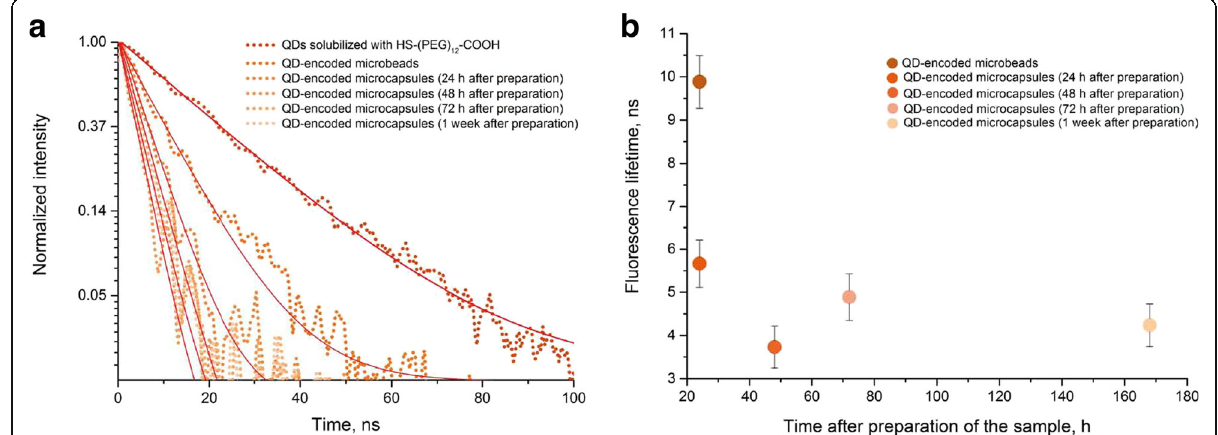
Fig. 8 Fluorescence lifetimes of the solubilized CdSe/ZnS quantum dots with a fluorescence peak at 590 nm incorporated in the fabricated microparticles and